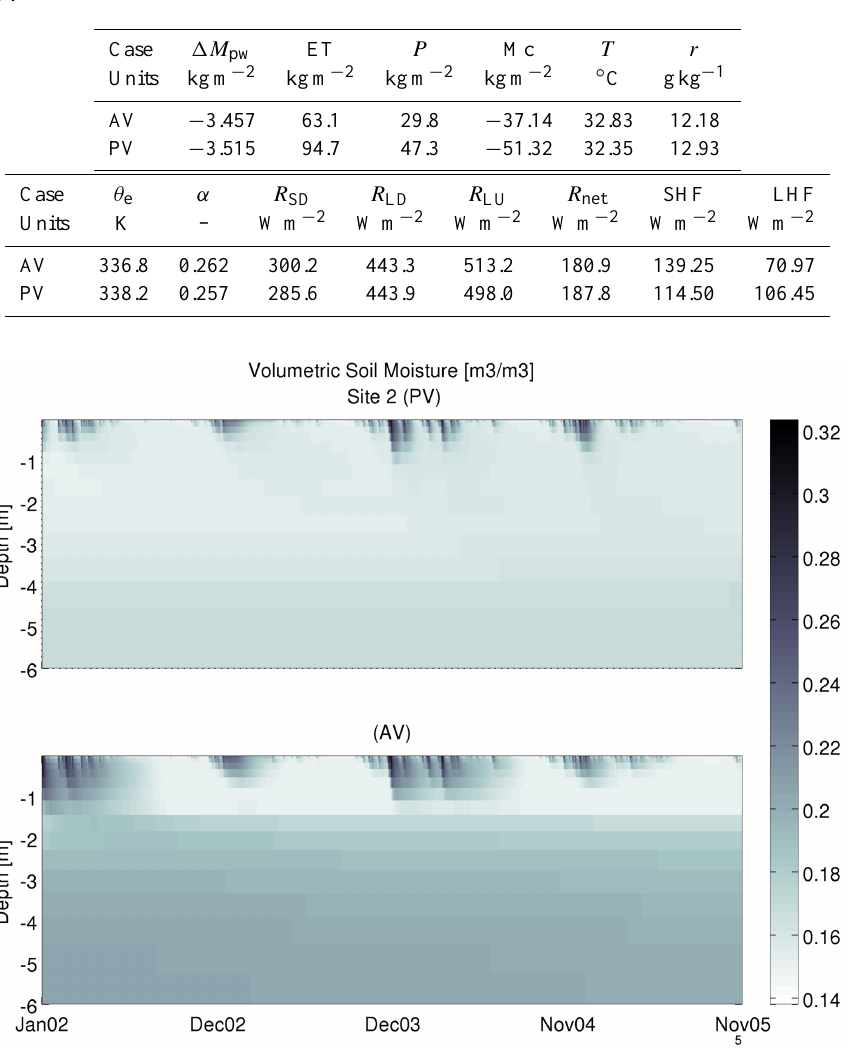
Figure 10. Time series profile of volumetric soil water at the Gran Chaco focus area. Both scenarios, potential (PV) and actual (AV), are shown